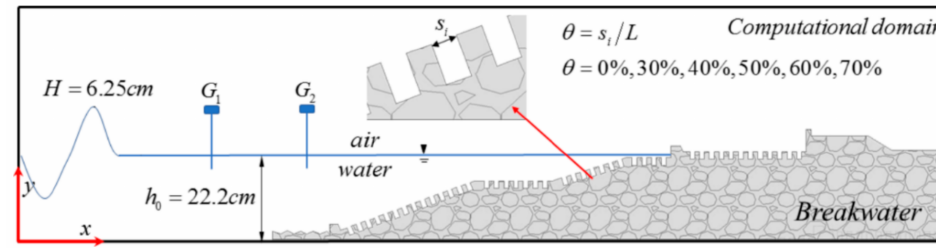
Figure 4. Schematic diagram of the numerical